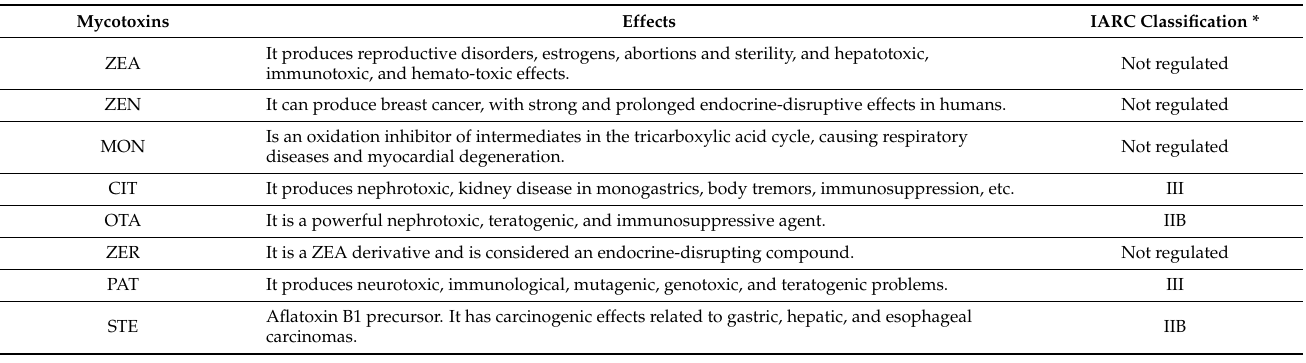
* Group IIA: probably carcinogenic to humans; there is limited evidence in humans but sufficient in animals. Group IIB: possibly carcinogenic; the evidence in humans is limited, and there is not enough evidence with experimental animals. Group III: not classifiable as a human carcinogen and cannot be included in another